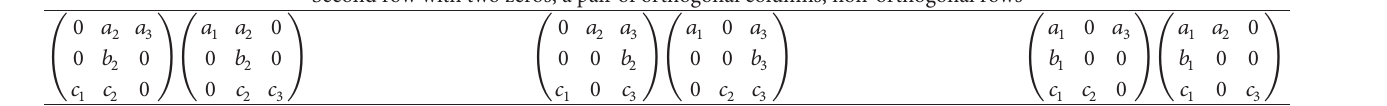
Second row with two zeros, a pair of orthogonal columns, non-orthogonal rows